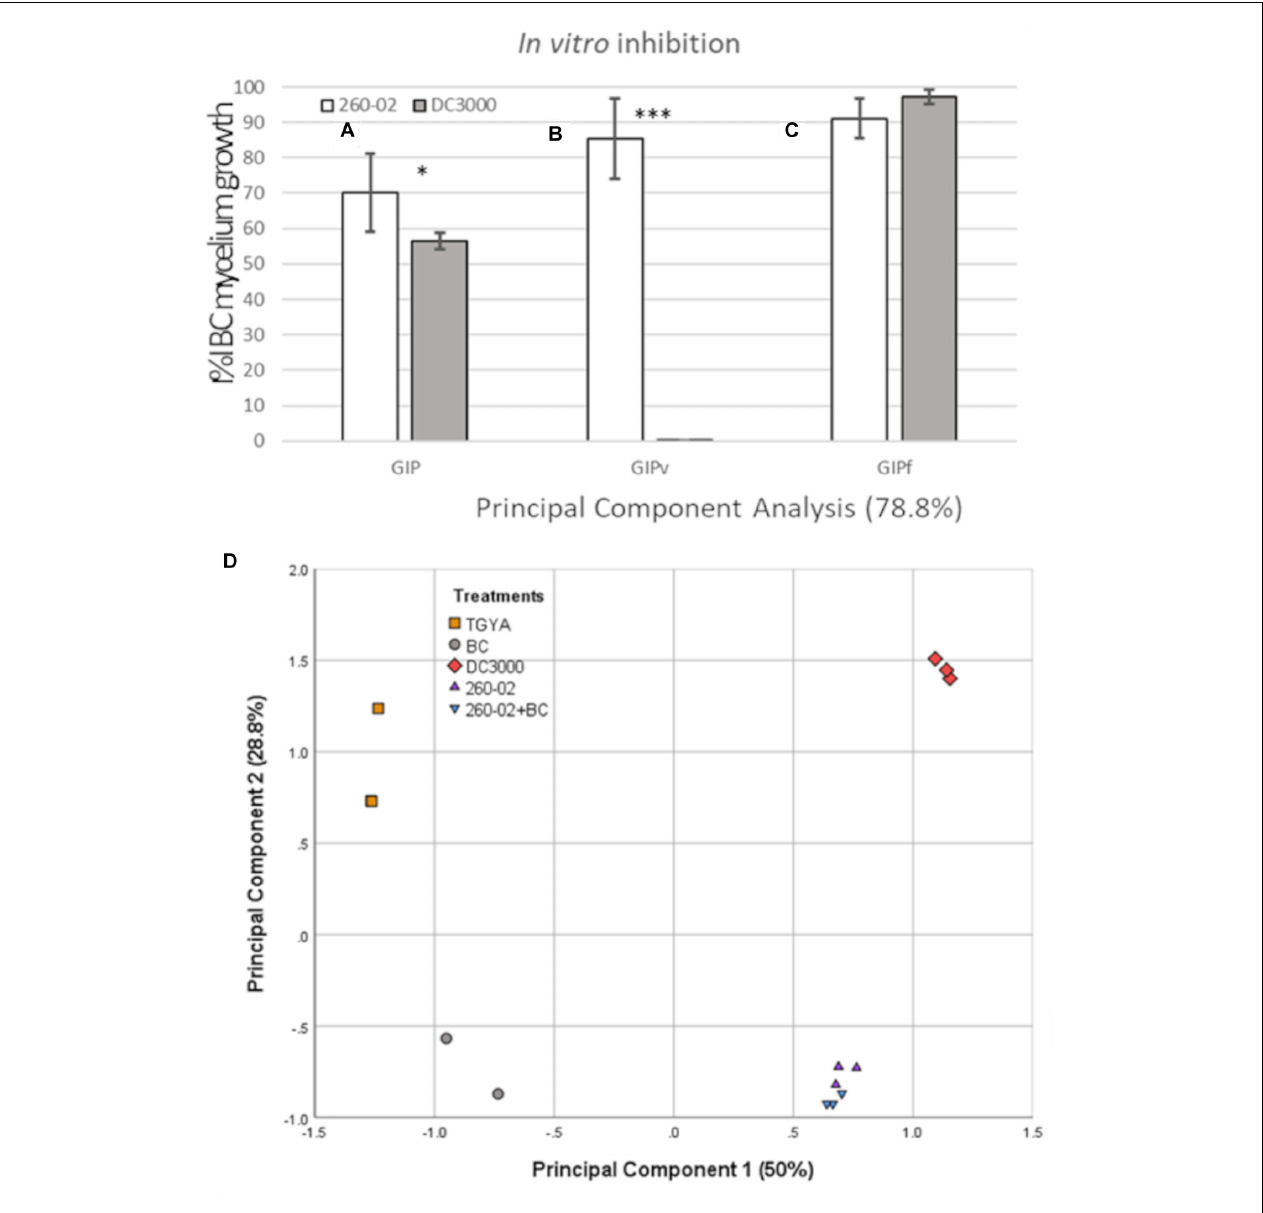
FIGURE 2 | Results of the in vitro assays. Graph reporting on the Y axis the percentage of inhibition of Botrytis cinerea growth observed in panel (A) the dual-culture assay (GIP), (B) the dual-plate assay, measuring the effect of volatiles alone (GIPv), and (C) on plates containing cultural filtrate (GIPf) values registered in the competition assays against B. cinerea MG53 using the strains 260-02 and DC3000. The bars represent the mean value of 3 independent measures taken on 3 biological replicates of the experiment. Statistically different results according to Student’s T -test are reported with asterisks ( ∗ p < 0.05; ∗∗ p < 0.01; ∗∗∗ p ≤ 0.001) (D) Principal component analysis describing 78.8% of the difference between the volatile molecules found in the sterile medium (TGYA), those produced by BC, by strain DC3000, by strain 260-02 alone, and by strain 260-02 cultured together with BC (260-02 +